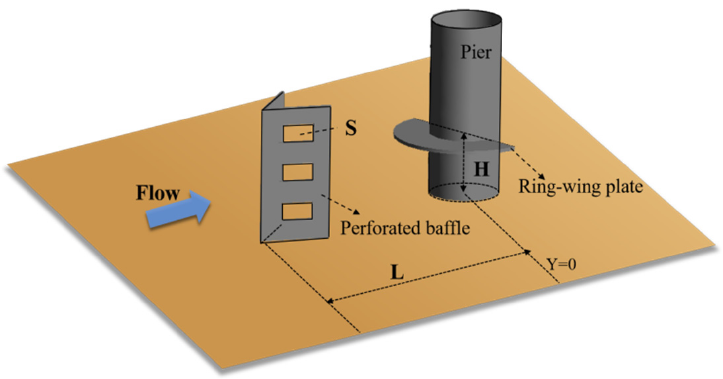
Figure 2. Sketch of the experimental setup.